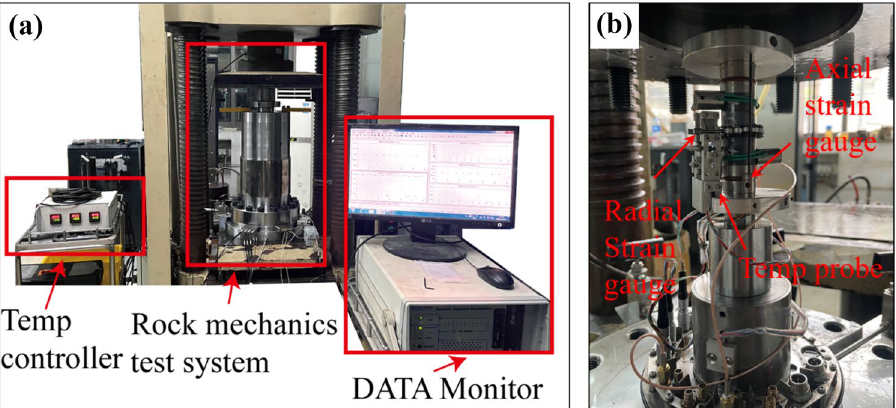
Fig. 3 Rock mechanics test system and strain